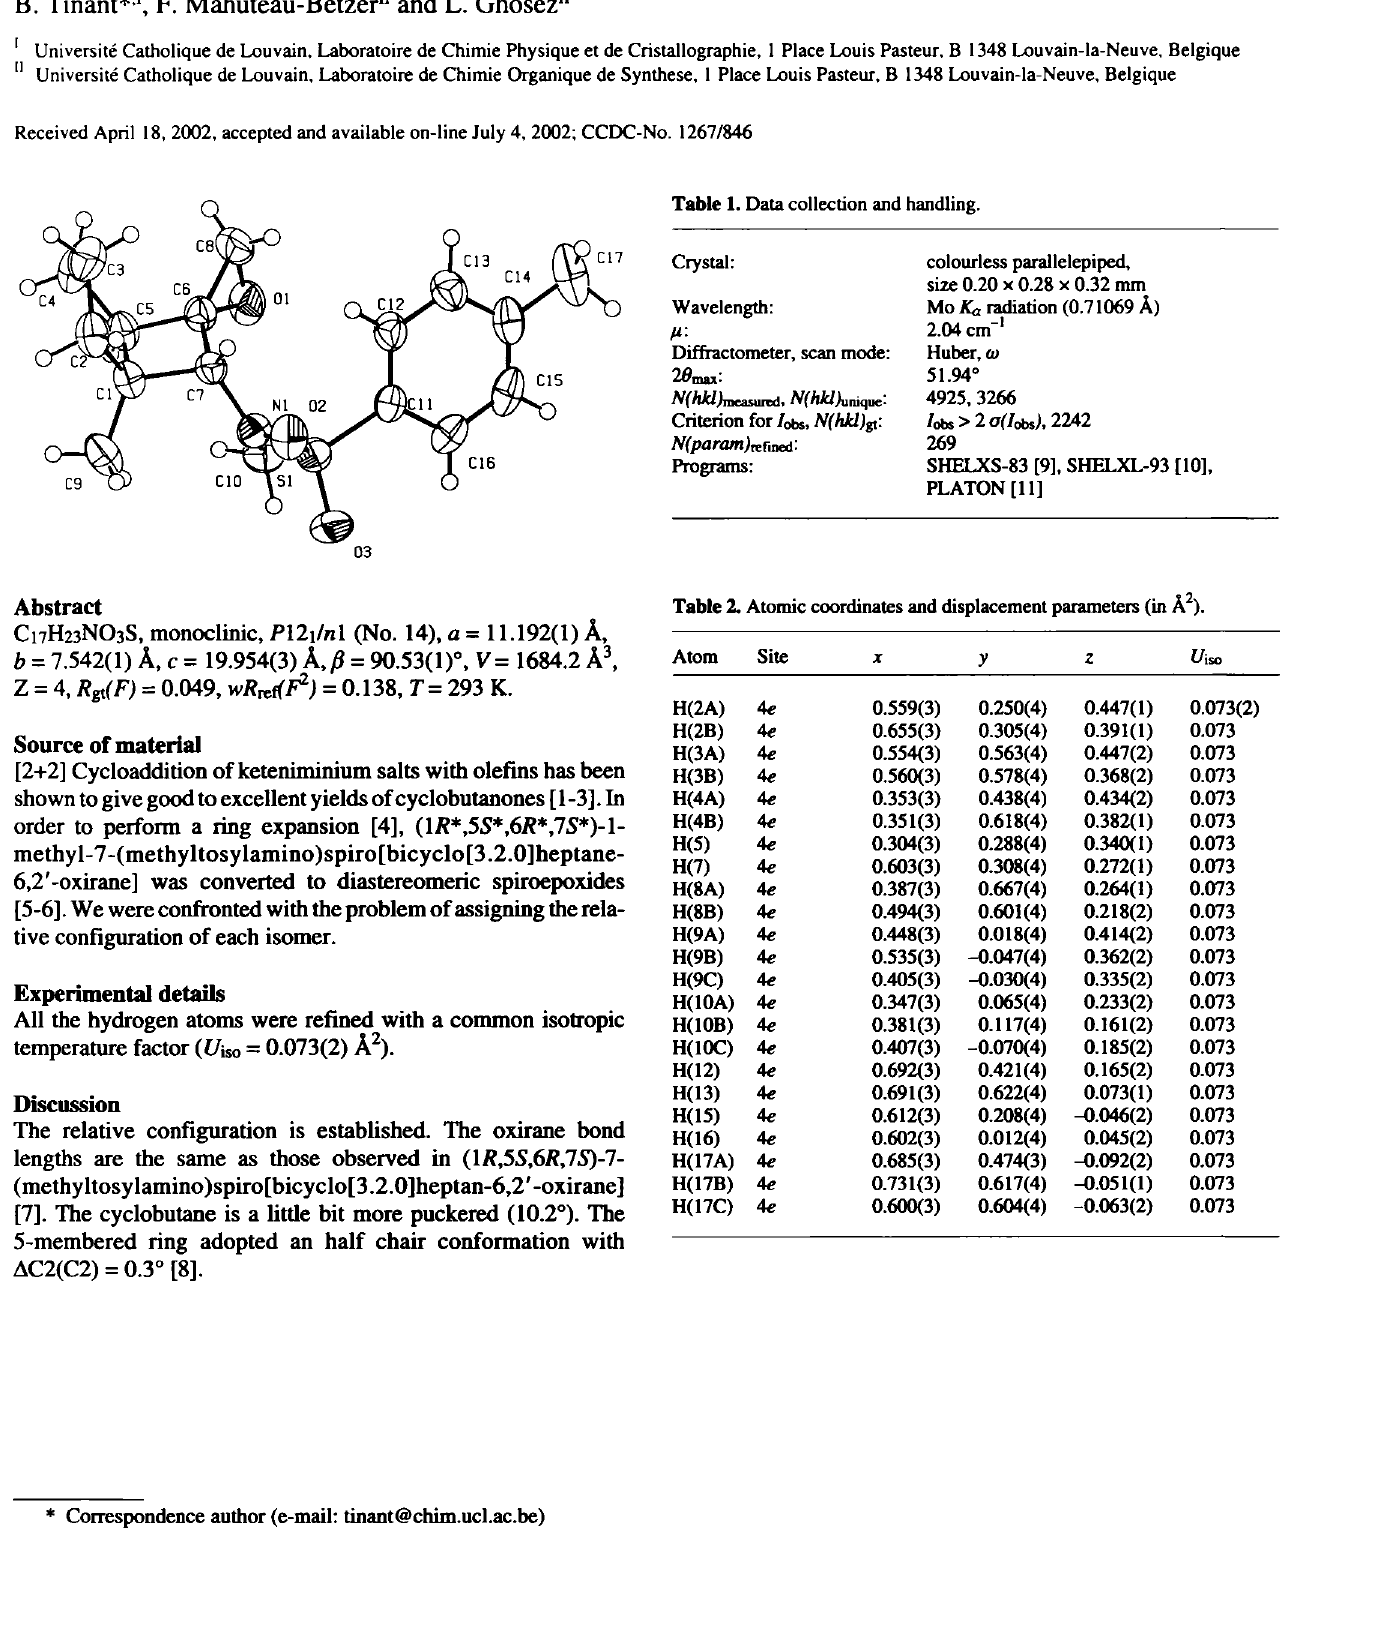
Table 1. Data collection and handling.